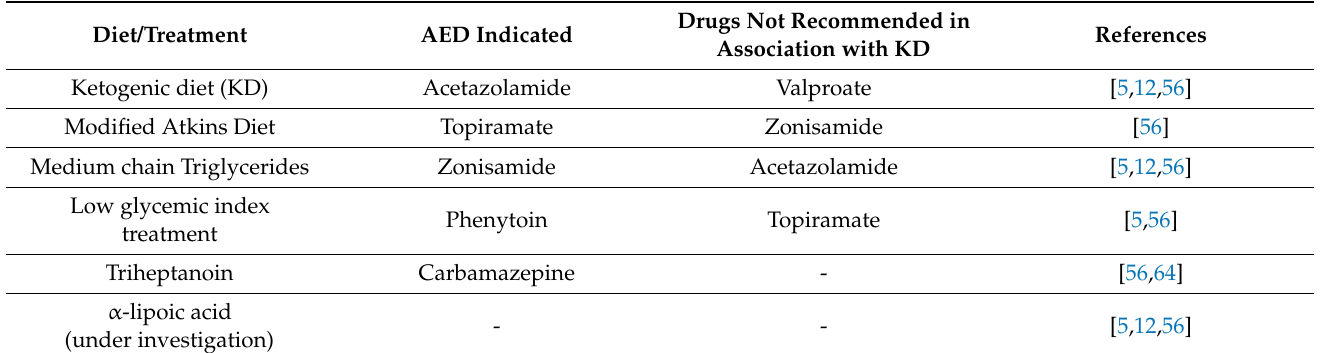
Table 2. Recommended treatments in cases with the epilepsy-associated phenotype of Glut1DS; diet treatments and antiepileptic drugs (AED) to